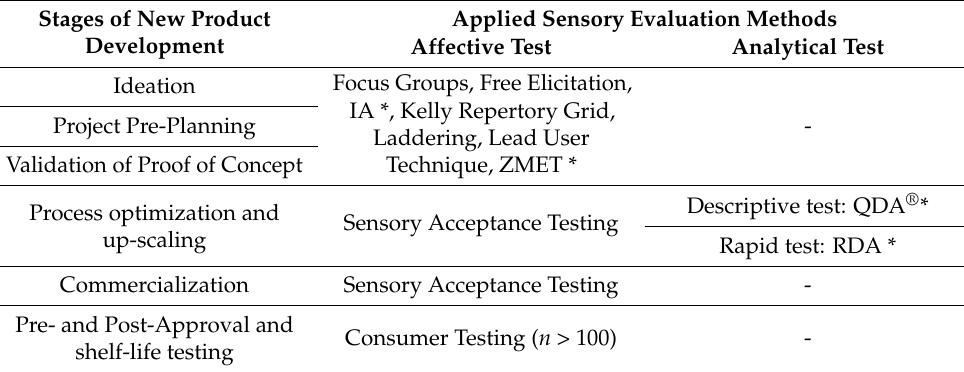
Table 2. Use of sensory evaluation methods on each step of new product development. Stages of New